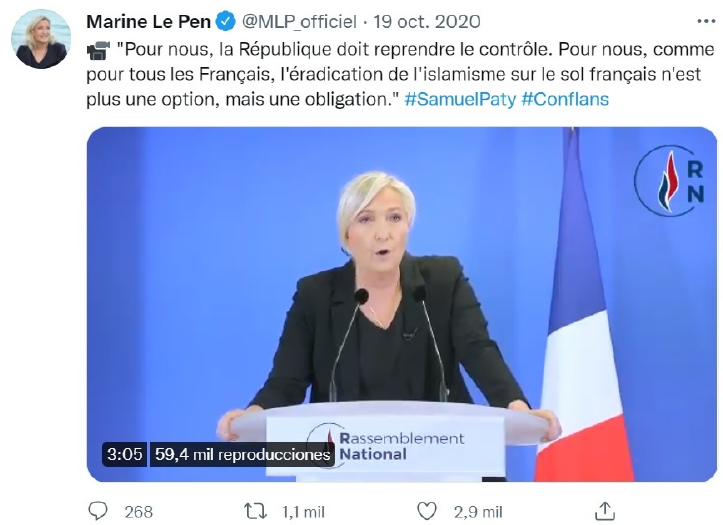
Figure 1. Tweet from Le Pen using the politicians as individuals’ frames.